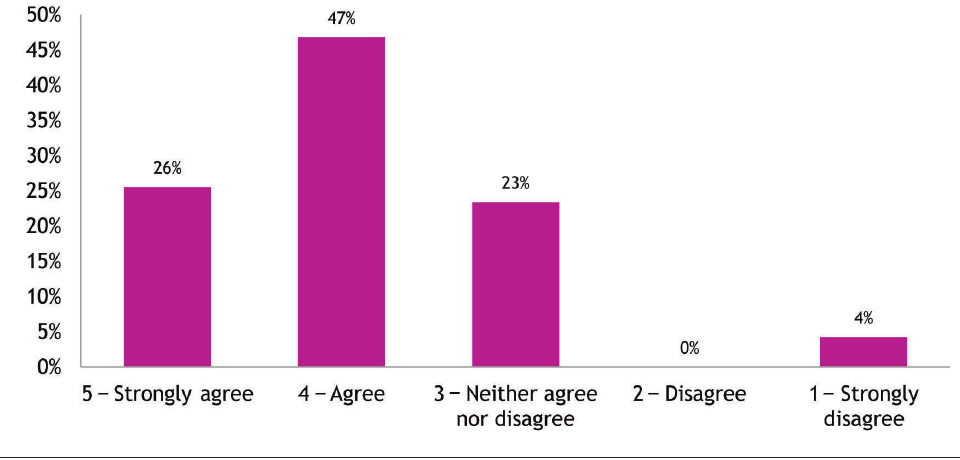
Figure 3: Chart showing audience response to the statement ‘Tactile Collider has helped me learn something new about